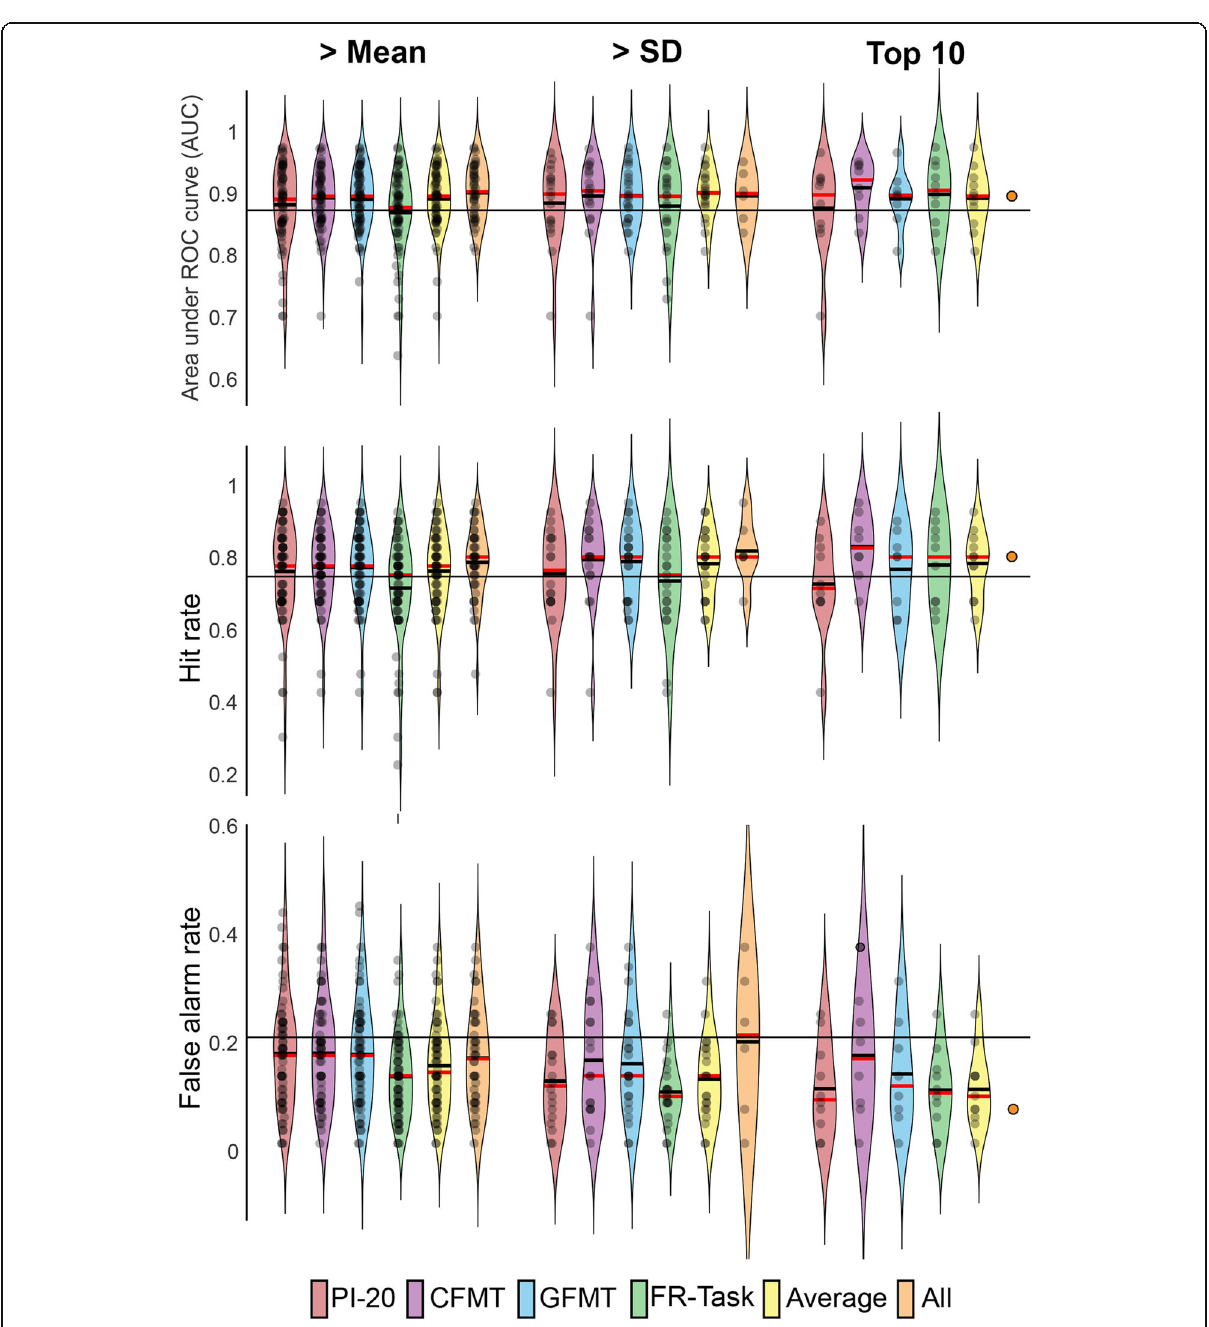
Fig. 3 Results of Analysis 2, showing session-two Face Recognition Candidate List Review Task (FR-Task) performance in groups selected using session one screening tests. Continuous black lines show the average of all participants ( n =114). Violin plots are presented in three columns pertaining to three selection thresholds (above mean, above one standard deviation (SD), top 10 performers), and show session-two FR Test performance for groups performing above the threshold in each screening measure. Within each violin, black lines represent group mean, red lines are the median, and data points are individual participants. Because only one participant was in the Top 10 performers for face identification accuracy on all screening tests, an orange point shows their performance. CFMT Cambridge face memory test, GFMT Glasgow face matching test, PI-20 20-item prosopagnosia index, ROC receiver operating